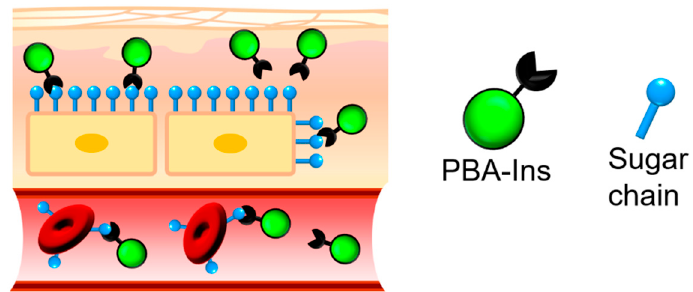
Figure 2. Expected interactions between PBA-modified insulin (PBA-Ins) and sugar chains on the cell surfaces in subcutaneous tissue and blood vessel. surfaces in subcutaneous tissue and blood